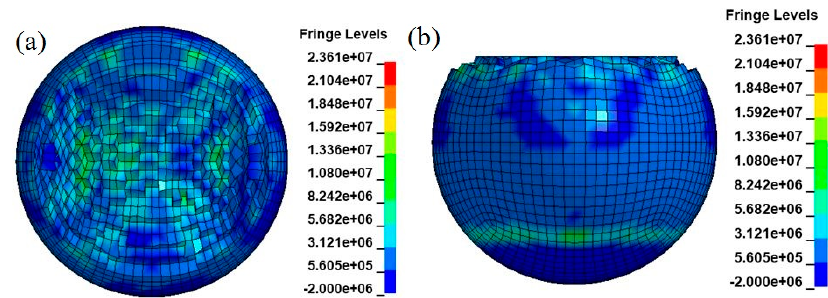
Figure 6. Damage of the ice ball at 0.5 s. ( a ) Main view ( b ) Side view.